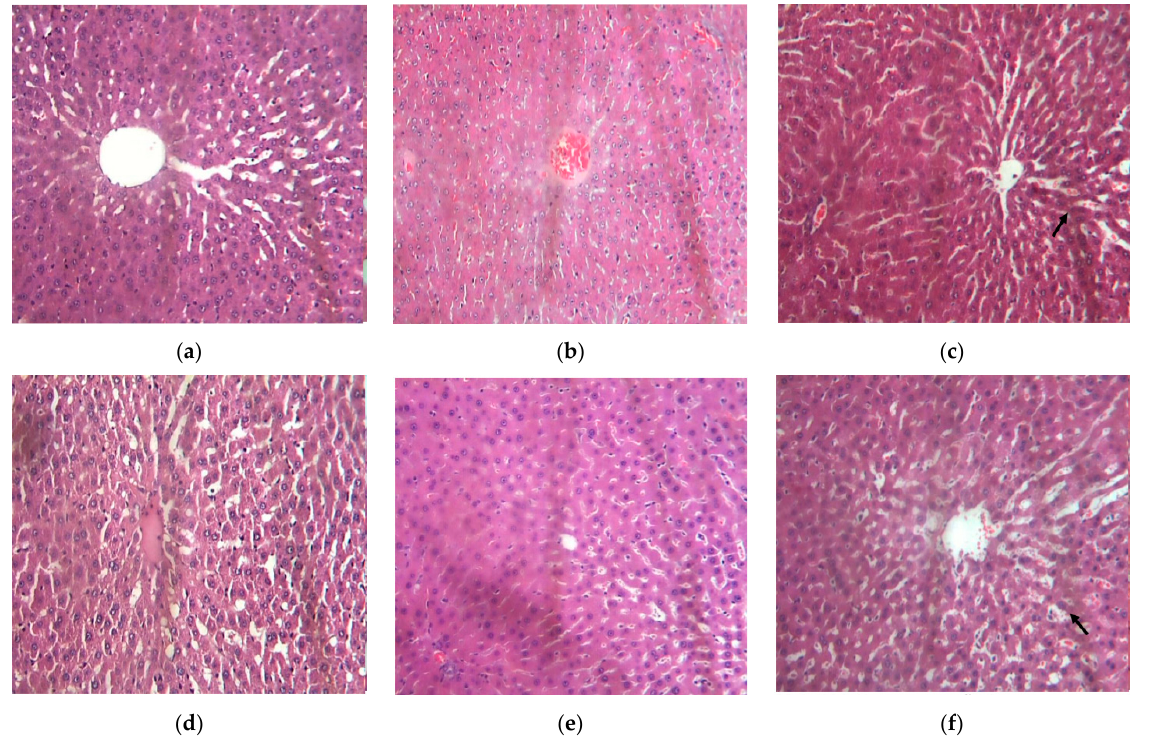
Figure 7. Representative photomicrograph of liver tissue from STZ-induced diabetic rats at the end of 4 weeks of treatment with bacuri seed butter (BSB). Legend: normal control ( a ); diabetic control (STZ) ( b ); STZ + BSB 25 mg/kg ( c ); STZ + BSB 50 mg/kg ( d ); STZ + BSB 100 mg/kg ( e ); STZ + insulin NPH 6 UI/day ( f ).